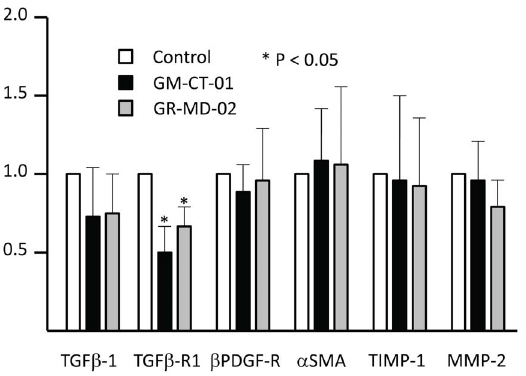
Figure 12. mRNA expression in LX-2 cells after 48 hours of culture. Drug concentrations were 0.1 mg/ml culture media. Data are expressed as mean and standard deviation. Statistics performed with t- tests as compared to control.